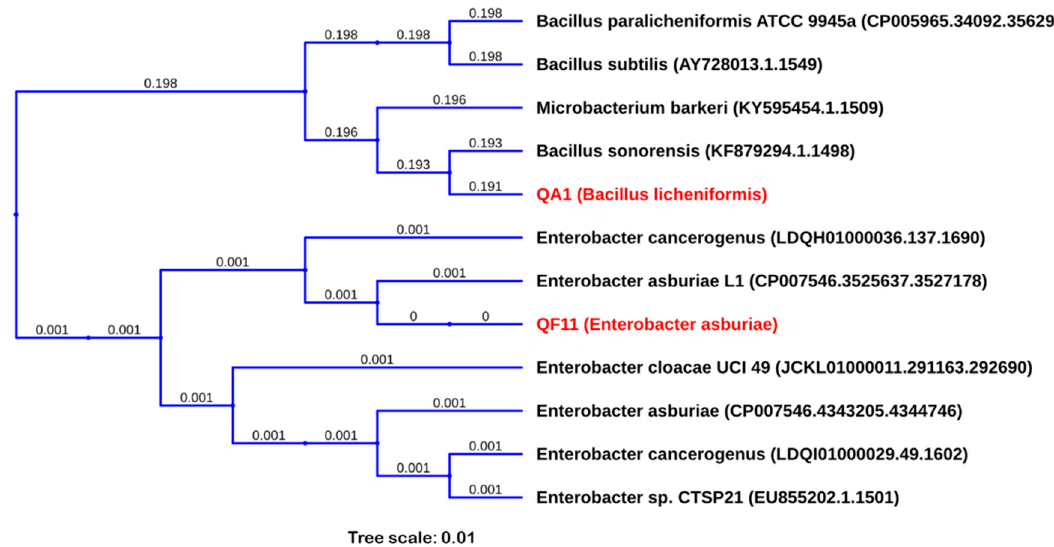
Figure 4. Phylogenetic tree of selected P-solubilizing bacteria, (QA1) Bacillus licheniformis (MN810040) and (QF11) Enterobacter asburiae (MN810041), based on PHYLIP Neighbor-Joining method of the 16S rRNA gene sequences using UGENE. The 16S rRNA gene sequences and tree of related species were downloaded from SILVA database.